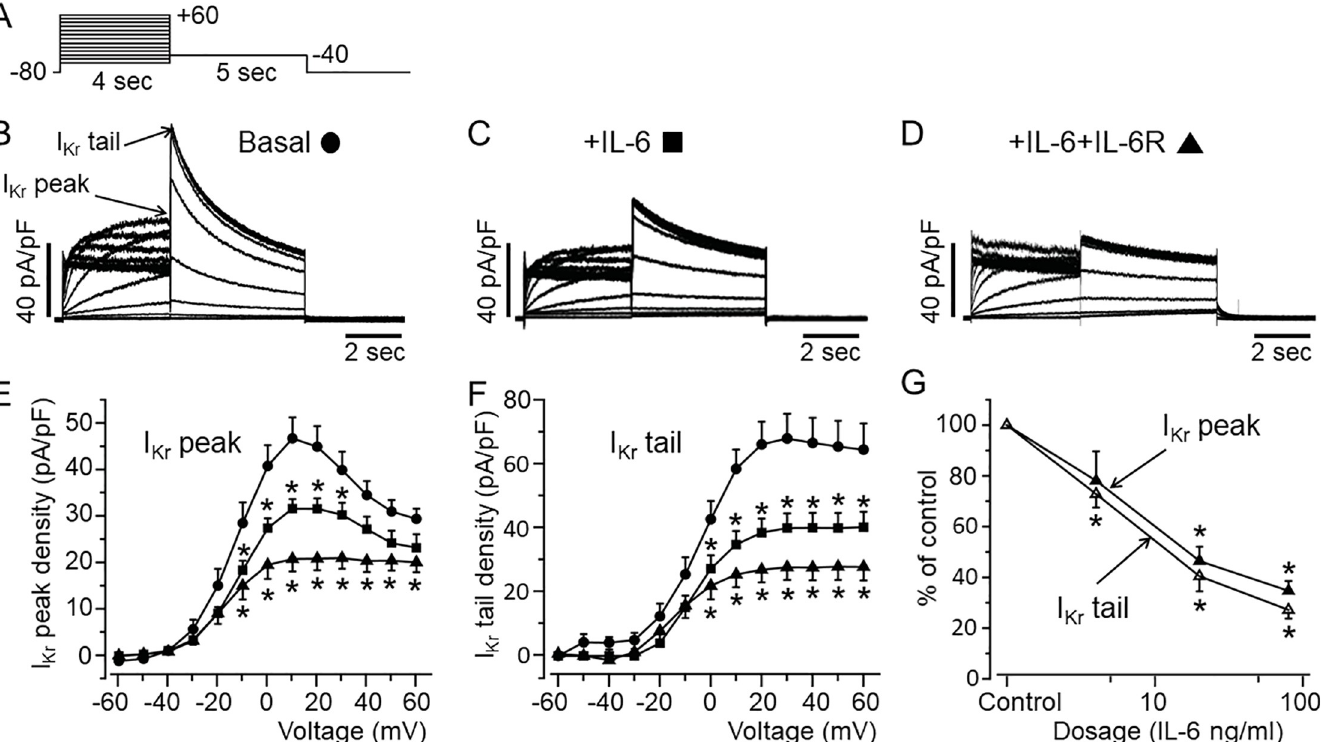
Fig 1. Functional effect of IL-6 on I Kr in HEK-hERG cells. A , Voltage-clamp protocol used to elicit I Kr in HEK-hERG cells stable expressing hERG channel. B , Control hERG current. Arrows indicate hERG peak and tail currents. C , I currents measured in cells pre-treated with IL-6 alone or D , with IL-6+IL-6R. E , I Kr density-voltage - curves for control (circle, n = 21), IL-6 alone (square, n = 18) and IL-6+IL-6R (triangle, n = 9). G , The dose-response effects of IL-6+IL-6R on I Kr peak and tail densities. Data were normalized to control and expressed as percentage of control.